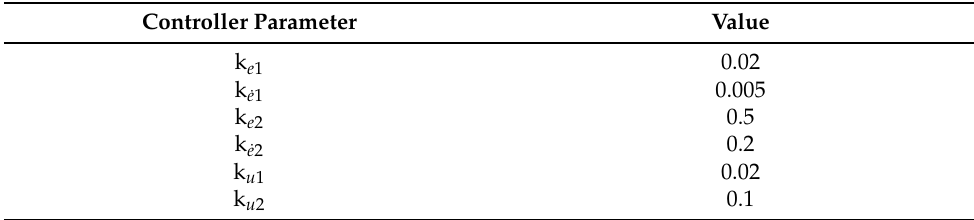
Table 6. Parameters of the nonadaptive fuzzy controller [6].